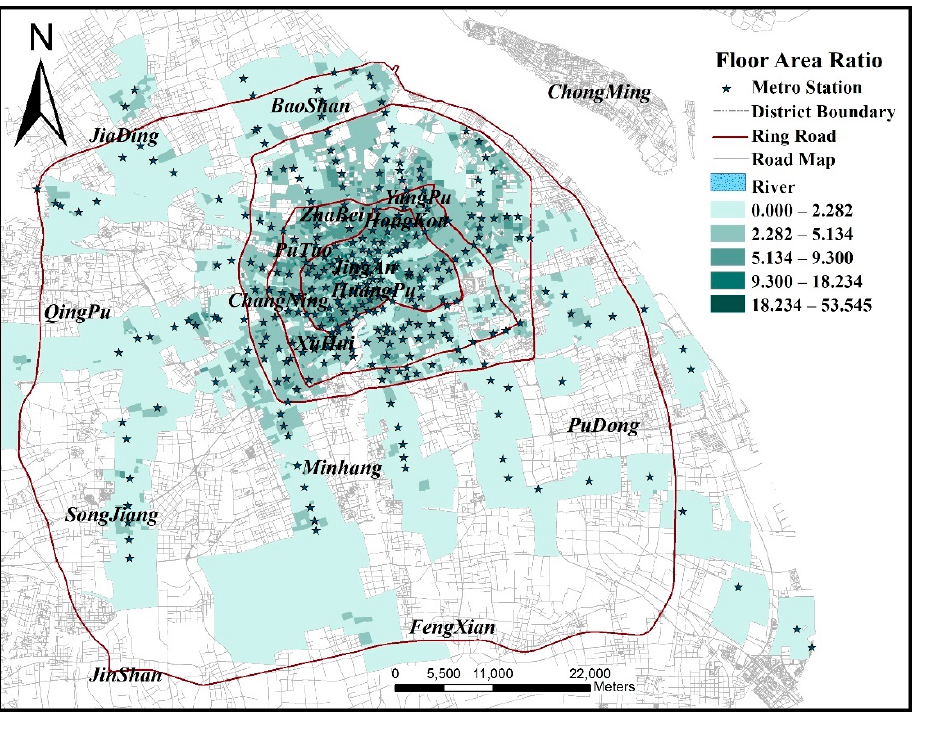
Figure 4. Urban Spatial Form within the catchment area of stations. Table 2. Average Floor Area Ratio in various service areas and